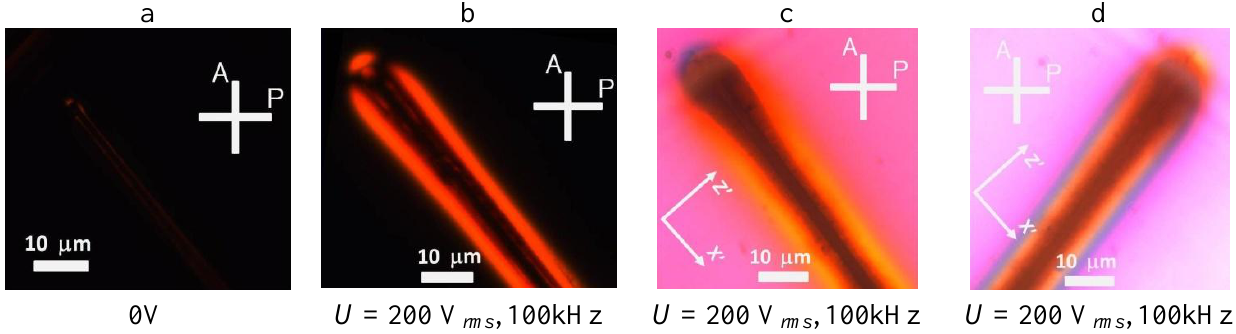
Figure 6. Polarizing microscope textures of the flat cell observed with crossed polarizers A and P. At zero electric field, the toluene dispersion of “short/thin” Au NRs is isotropic and the field of view is dark (a) . When the voltage is on ( U = 200 V birefringent cloud of aligned Au NRs appears near the central electrode (2) (b) . When an optical compensator Z‟X‟, a 530 nm waveplate, is inserted between the sample and the analyzer, yellow and blue interference colors reveal that the field-induced birefringence is negative [ (c) and (d) ]. Note that reorientation of the sample by 90 degrees from (c) to (d) causes an interchange of the yellow and blue regions.